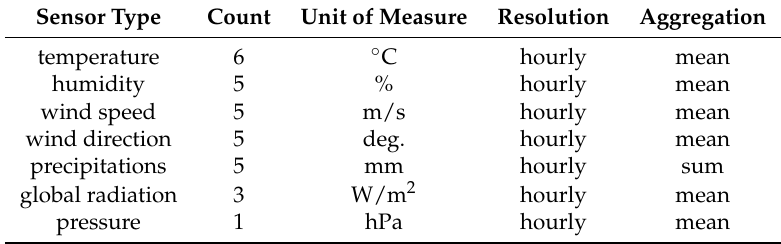
Figure 1. Map displaying the distribution of weather (blue), pollutants (green) and transit (orange) sensor stations around the city center of Milan. Table 1. Weather sensors divided by feature type, with amount of unique sensors per group, unit of measurements, time interval between samples and aggregation type used to unify the data